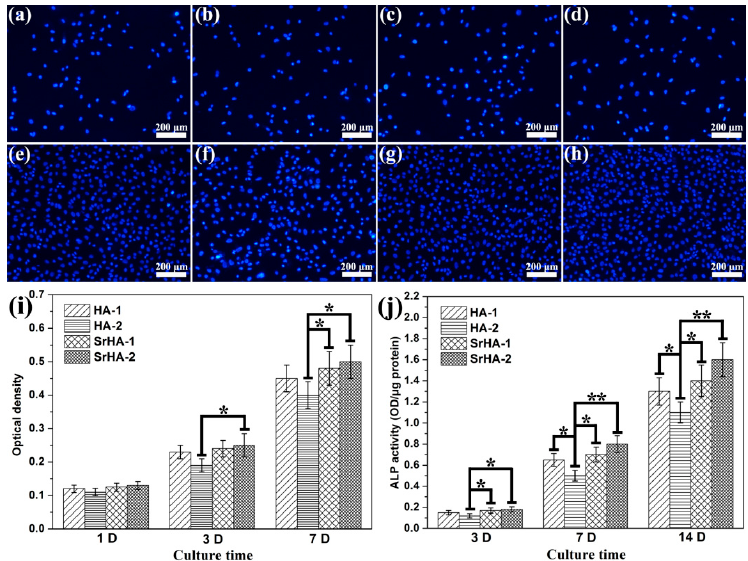
Figure 8. MG63 cell adhesion and distribution after one ( a – d ) or three ( e – h ) days of incubation. ( a , e ) HA-1, ( b , f ) HA-2, ( c , g ) SrHA-1, and ( d , h ) SrHA-2. ( i ) MG63 cell proliferation after one, three, and seven days of incubation measured by colorimetric MTT assay. ( j ) ALP activity of MG63 cells after three, seven, or 14 days of incubation. Statistically significant differences ( * p < 0.05, ** p <